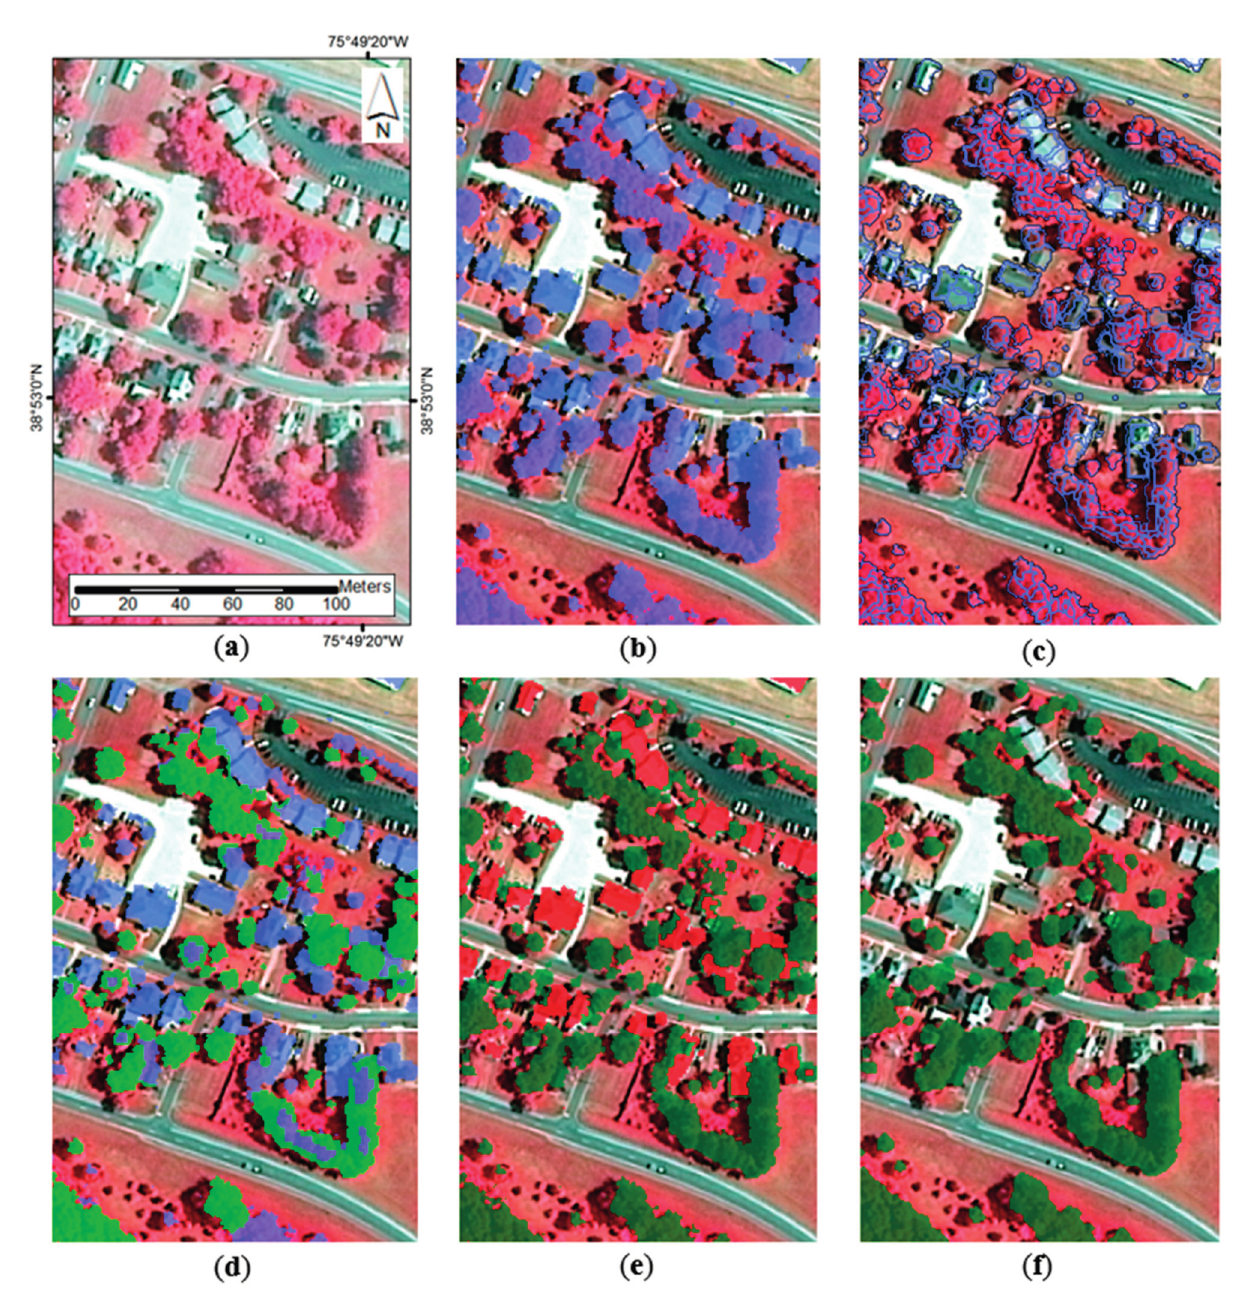
Figure 4. Segmentation workflow for tree canopy mapping using a combination of an nDSM and nDTM. ( a ) 1-m GSD 4-band NAIP Imagery for Caroline County, Maryland, USA. ( b ) Initial segmentation of tall objects (temporary class _Temp , in blue) using nDSM. ( c ) Re-segmentation of tall objects. ( d ) Identification of objects very likely to be trees based on nDSM/nDTM Difference and NDVI (light green objects). ( e ) Differentiation of trees from buildings using nDSM/nDTM Difference, spectral criteria, object size, slope, and adjacency (tree canopy in dark green, buildings in red). ( f ) Final Tree Canopy class after error checking and morphological